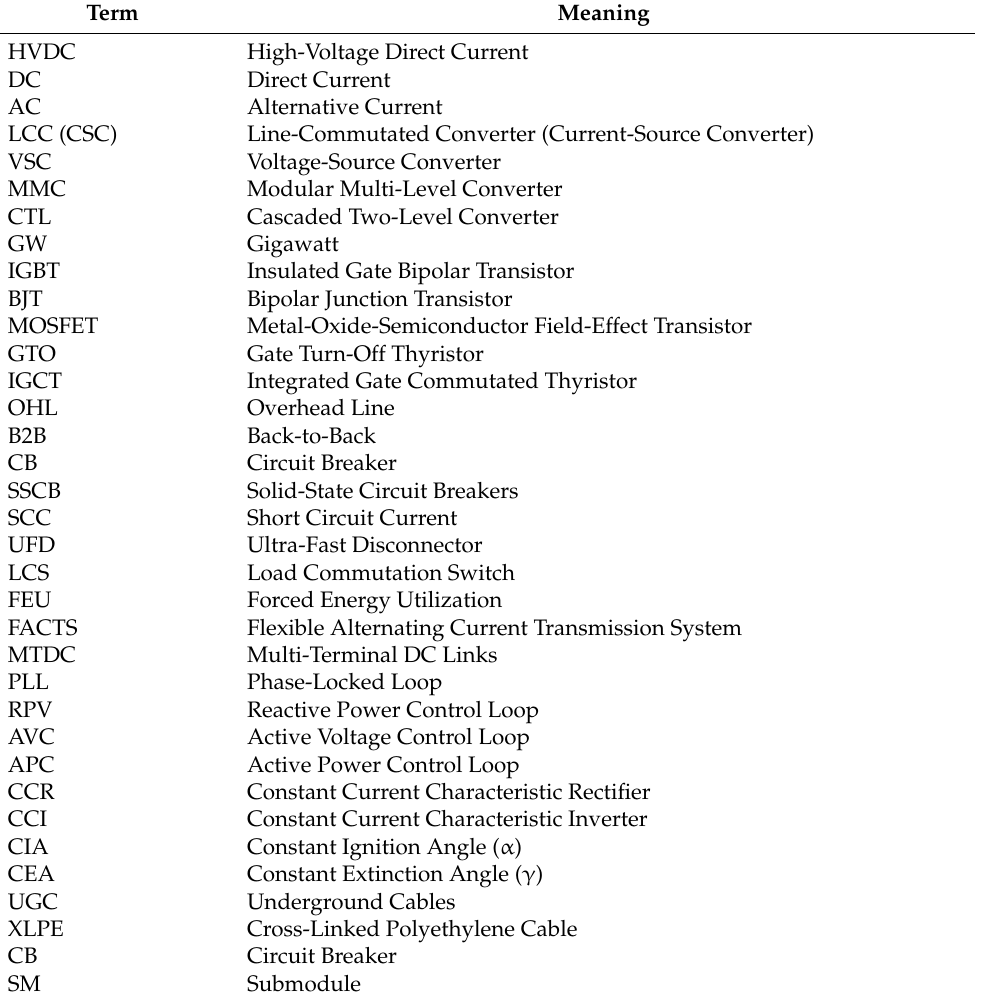
Table 1. A list of abbreviations and terms used in the